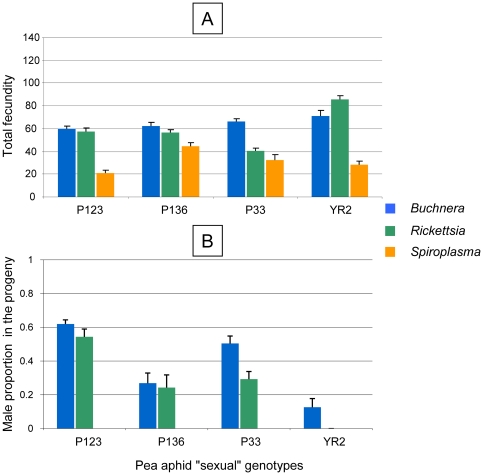
Influence of symbiont component on history traits of artificially infected lines of four “sexual” genotypes of the pea aphid exposed to conditions increasing male production (experiment 2).A) fecundity and B) sex ratio (given as the proportion of females in the sexual fraction of the progeny).